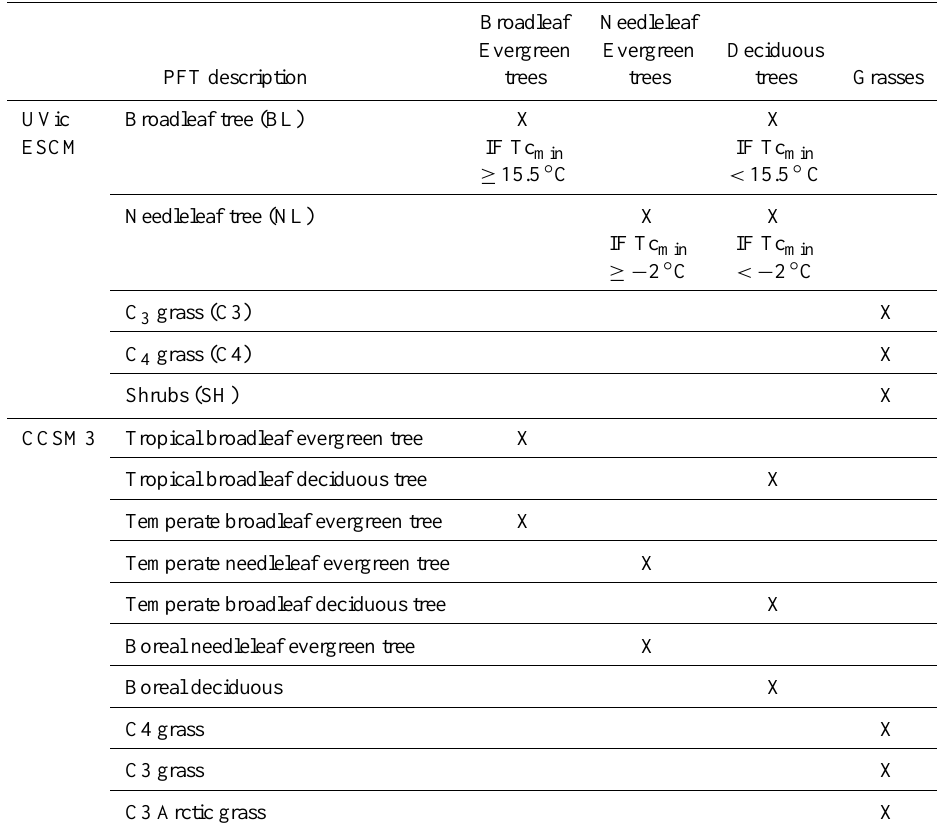
Table 1. The original PFTs as simulated by the UVic ESCM and CCSM3 are combined into four main types of PFTs to simplify the model intercomparison (Bonan and Levis, 2006). The UVic ESCM classification also makes use of the lowest temperature criteria (e.g. Kaplan et al., 2003; Sitch et al., 2003). Broadleaf Needleleaf Evergreen Evergreen Deciduous PFT description trees trees trees Grasses UVic Broadleaf tree (BL) X ESCM IF Tc min IF Tc min ≥ 15.5 ◦ C < 15.5 ◦ C Needleleaf tree (NL)